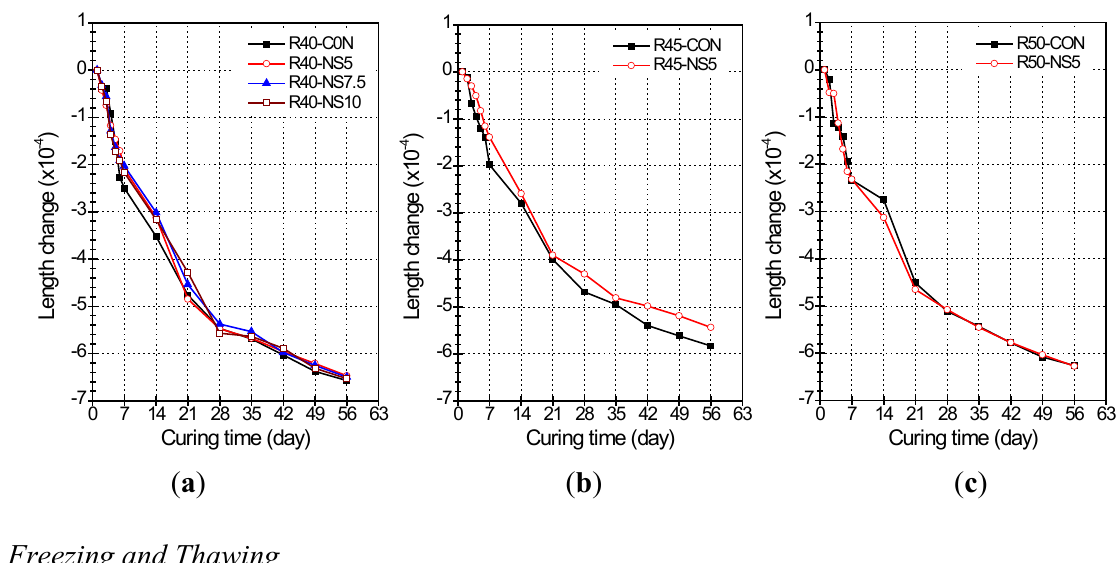
Figure 3. Length change of prism beams with ( a ) W/C of 40%; ( b ) W/C of 45%; and ( c ) W/C of 50% in relation to W/C and curing time (unit: